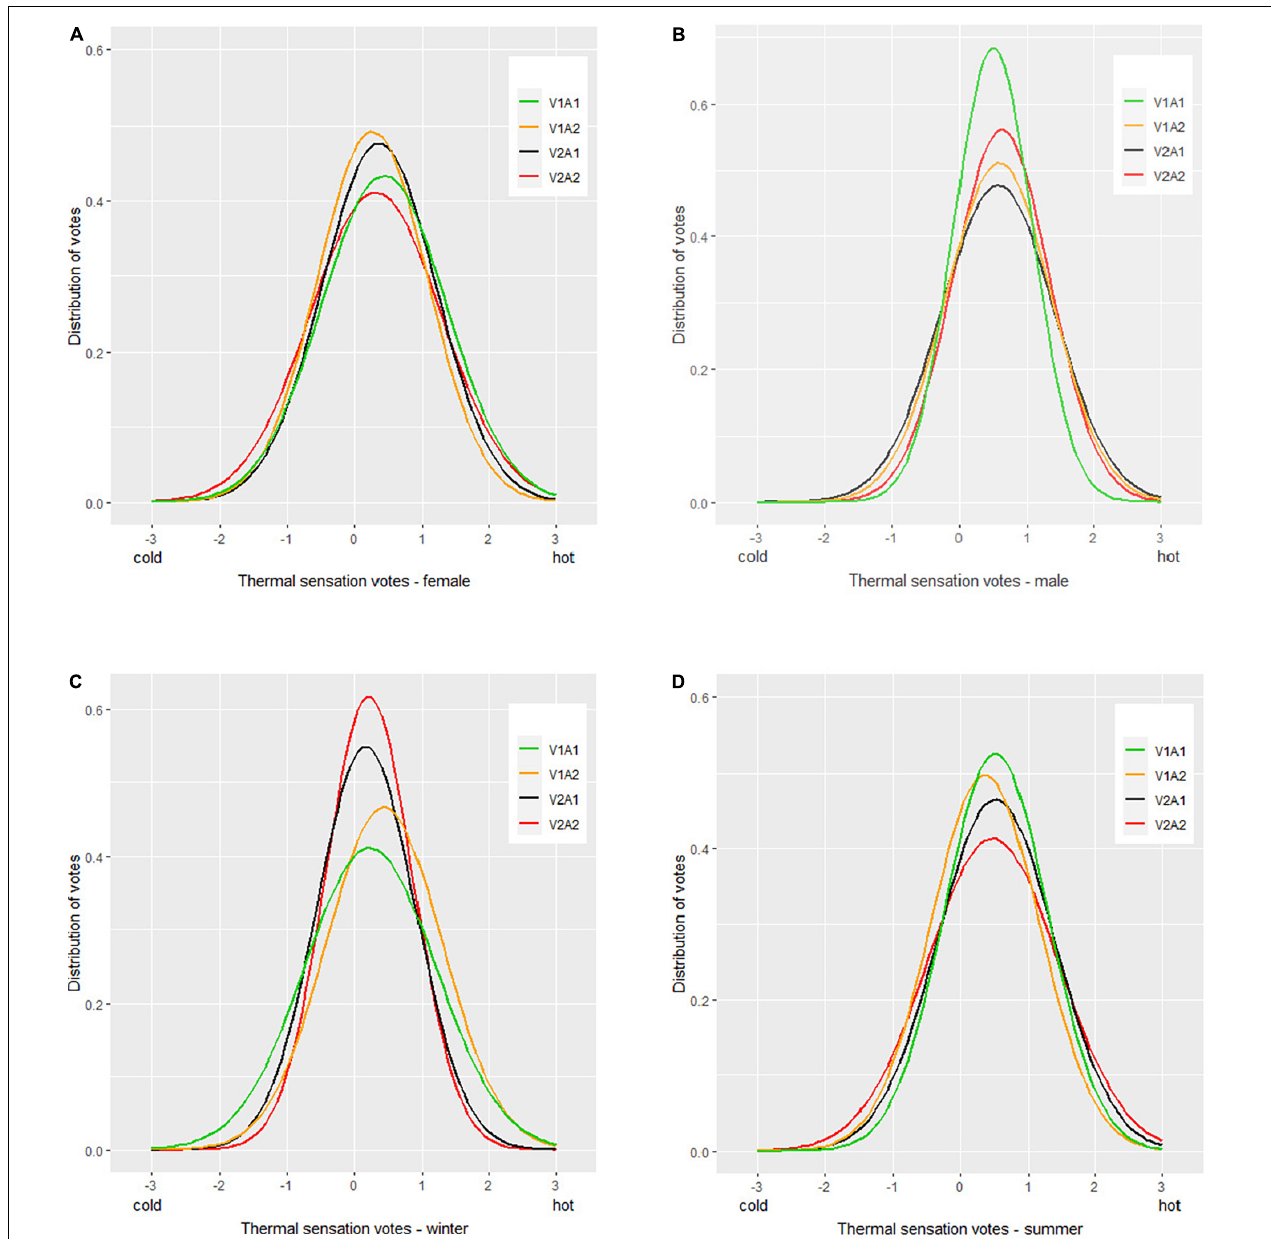
FIGURE 5 | Distribution of the evaluation of thermal sensation of participants differentiated based on gender [female (A) and male (B) ] and experimental time period [winter (C) and summer (D)